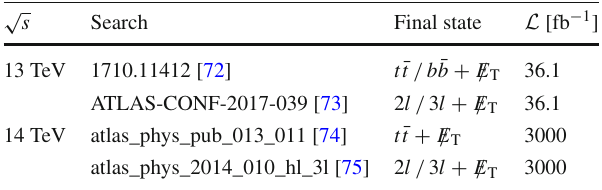
Table 2 List of experimental searches sensitive to our model, where l denotes electron and muon. The third column describes the final state targeted by the analysis and the last column displays the total integrated